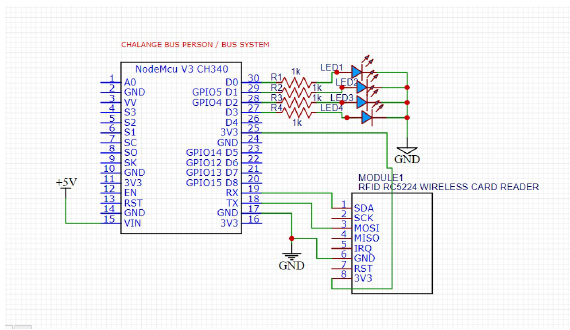
Figure 3. Connection Diagram of Bus